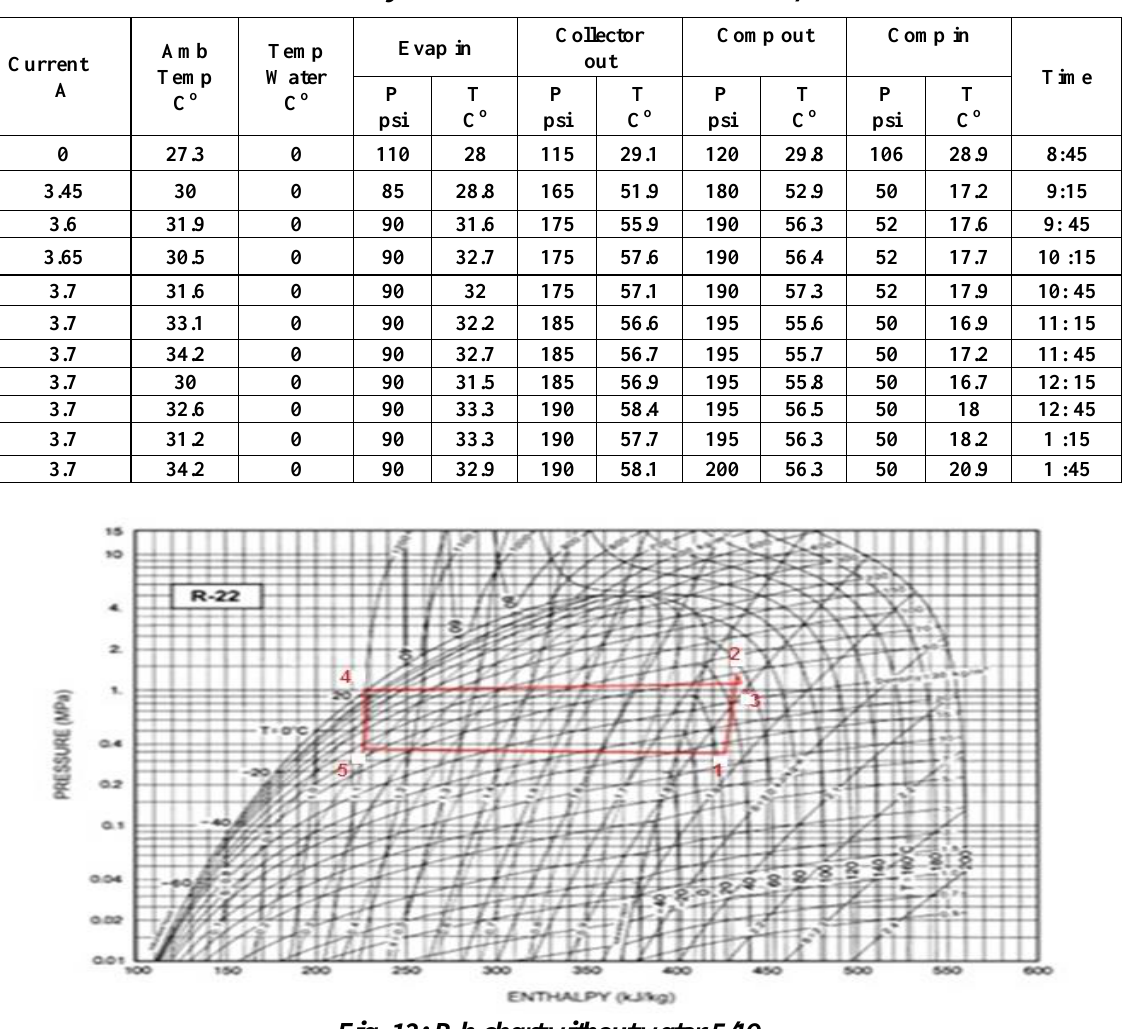
Table 4: Hybrid solar collector without water 5/10.